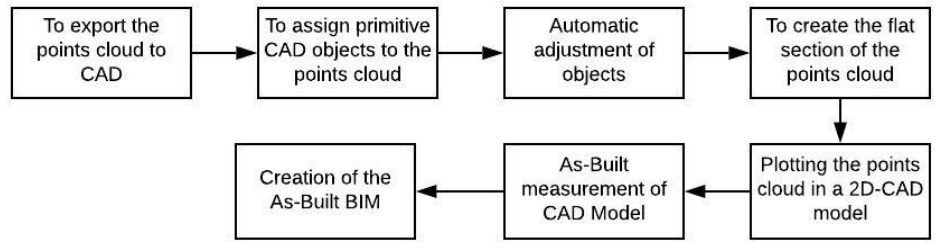
Figure 3. Exporting of the points cloud to CAD for BIM modeling.